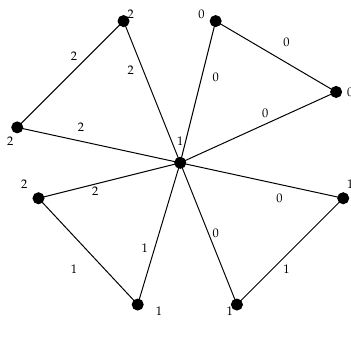
Figure 15. 3-TEMC labeling of F